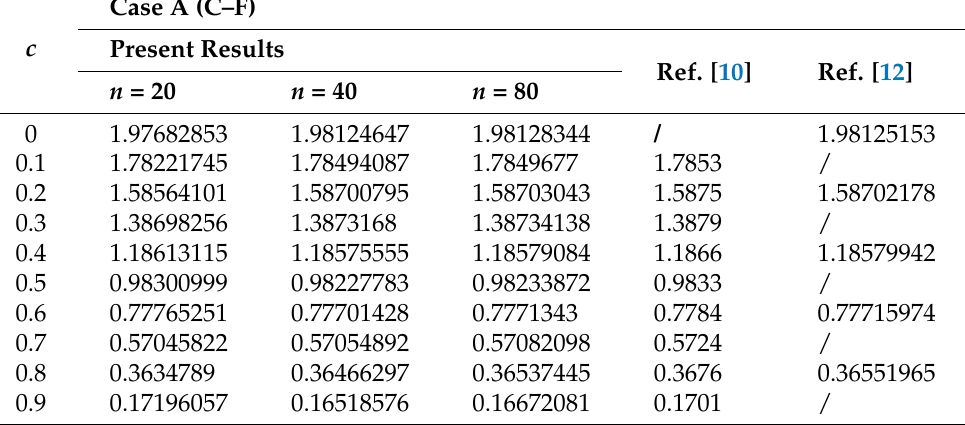
Table 1. Dimensionless critical load of a C–F axially FG Timoshenko beam with different taper coefficient ( m =